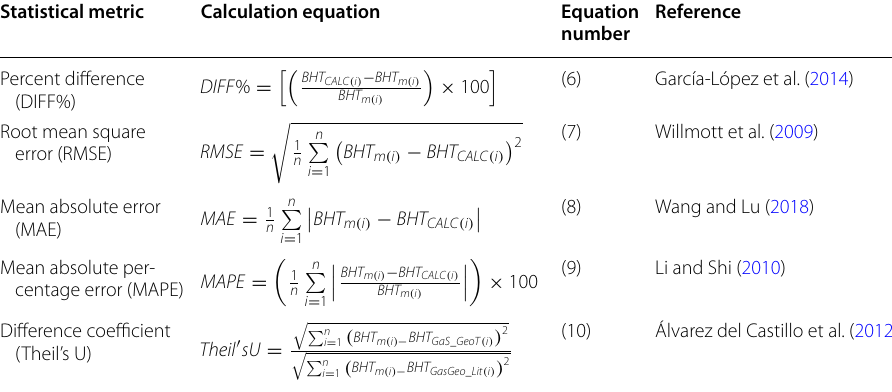
Table 9 Statistical metrics used for evaluating the prediction efficiency of gas geothermometers (new and